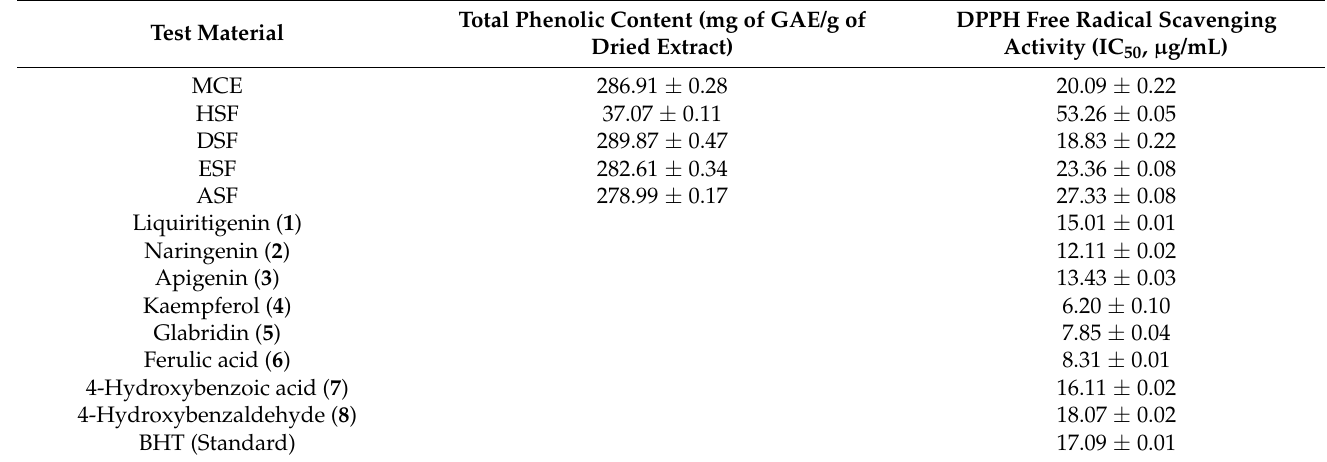
Table 2. The total phenolic content of different fractions of the W. tinctoria stem, and DPPH free radical scavenging activity with IC 50 values of various solvent fractions of the W. tinctoria stem and its derived phenolic compounds.